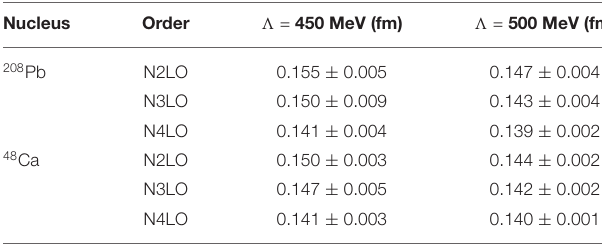
TABLE 5 | Predicted neutron skin of 208 Pb and 48 Ca. Nucleus